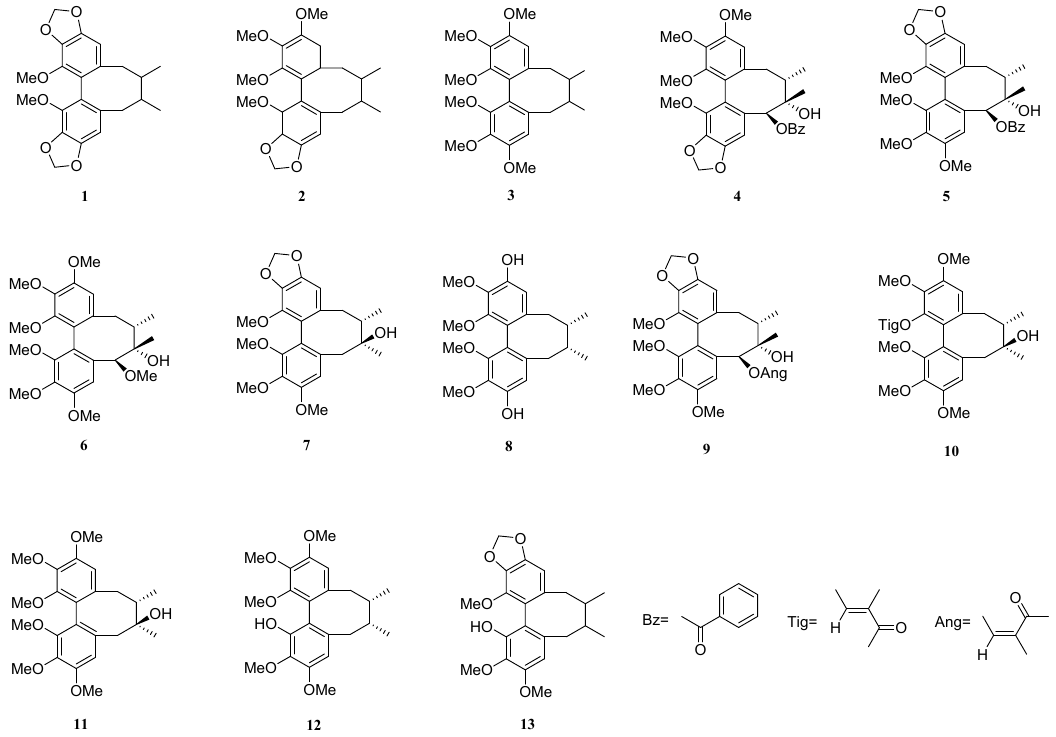
Figure 3. Structures of compounds 1 – 13 from total dibenzocyclooctadiene lignans of S. chinensis.